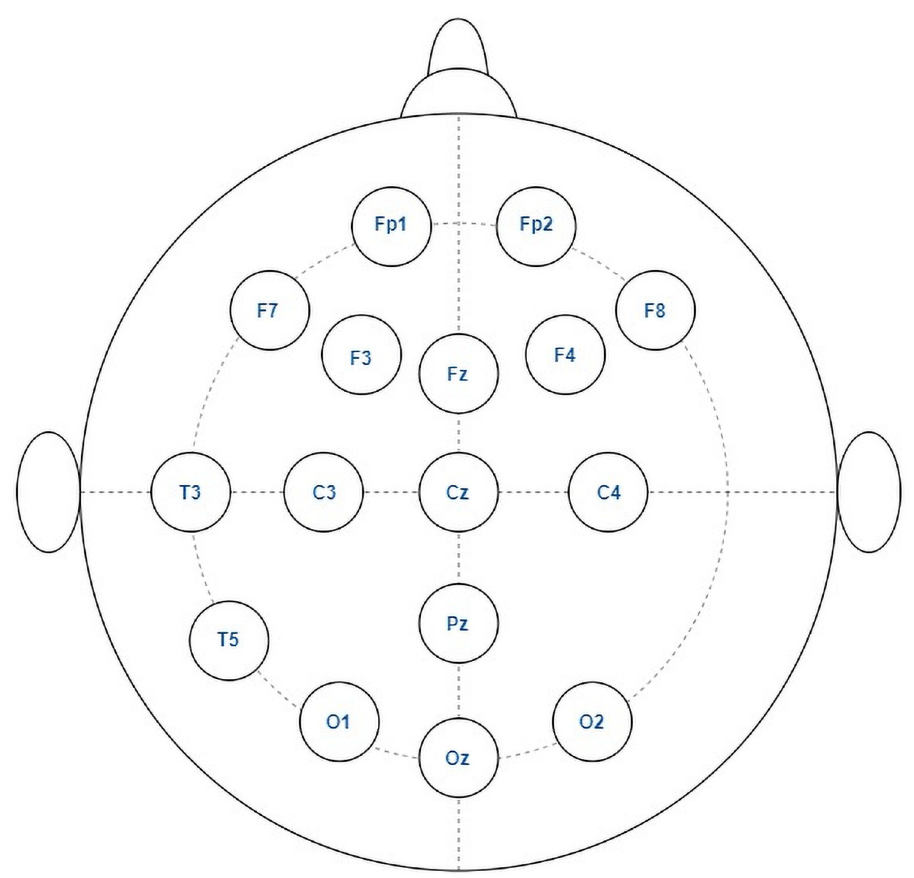
Fig 5. Electrodes placement of autism data acquisition system by